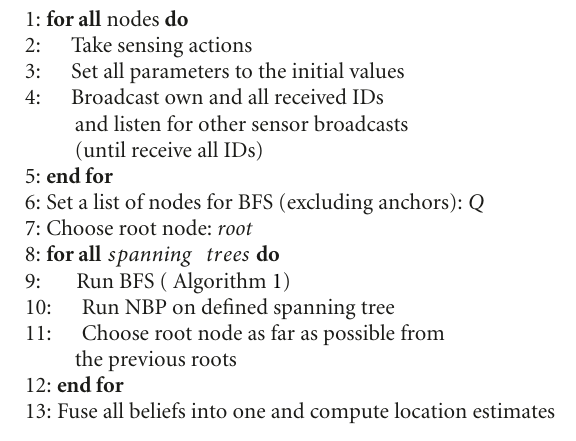
Algorithm 2: NBP-ST method for